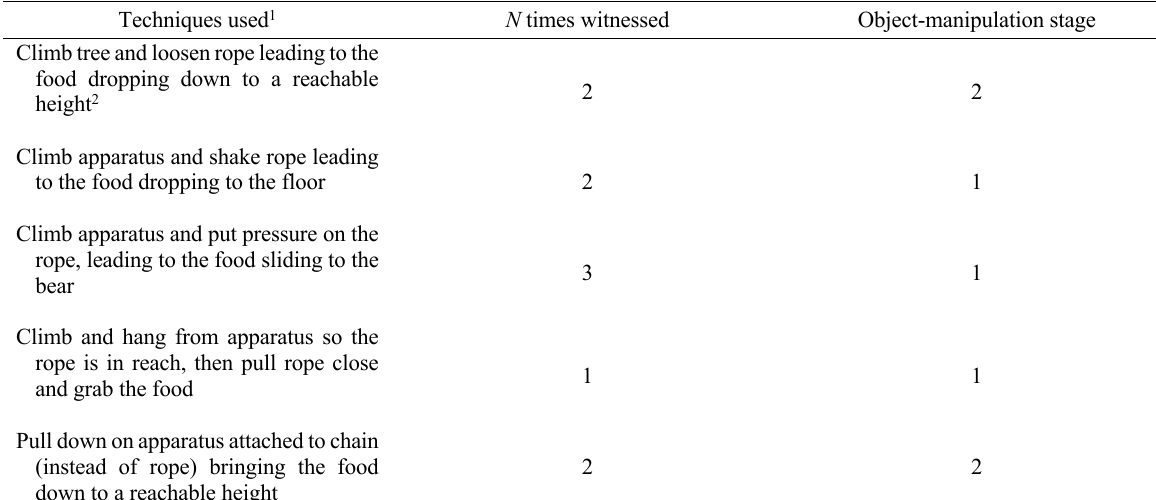
The Alternative Techniques Implemented by the Bears When Solving the Object-Manipulation Set-Up Techniques used 1 N times witnessed Object-manipulation stage Climb tree and loosen rope leading to